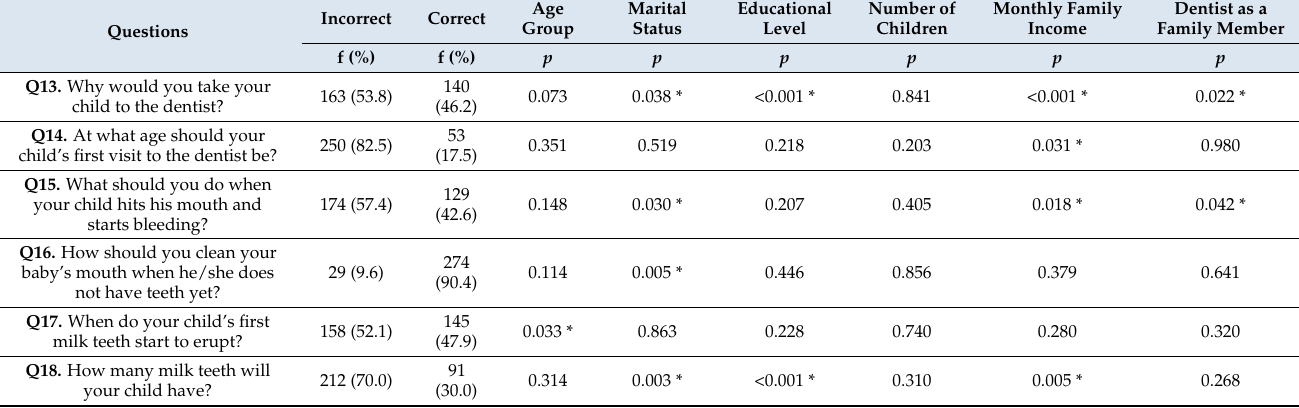
Table 4. Knowledge of early postpartum women about dental care in infants aged 0 to 2 years old, associated with sociodemographic factors.